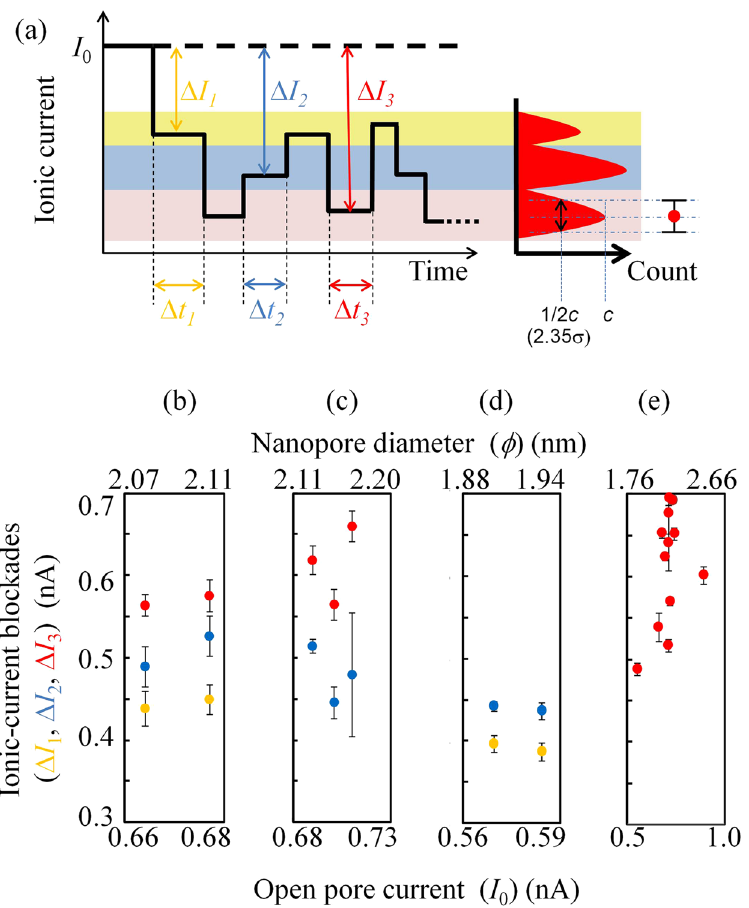
Figure 7. Relationship between the open pore current and Δ I . ( a ) Schematic of the time trace of the ionic current while DNA remained in the nanopore. Δ I 1 < Δ I 2 < Δ I 3 are represented in orange, blue and red, respectively. ( b ) Data for when [(dT) 25 -(dC) 25 -(dA) 50 ] m remained in the nanopore. ( c ) Data for when [(dA) 50 - (dC) 50 ] m remained in the nanopore. ( d ) Data for when [(dT) 25 -(dC) 25 ] m remained in the nanopore. ( e ) Data for when poly(dA) 5.3k remained in the